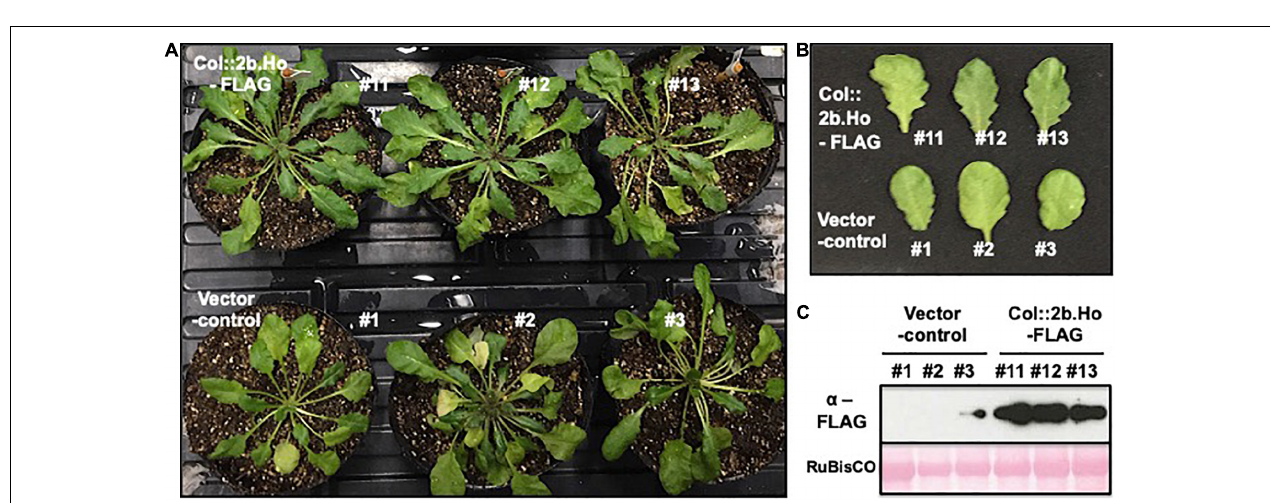
FIGURE 10 | Asymptomatic phenotype of A. thaliana ecotype Col-0 transformed with FLAG epitope sequence-tagged cDNA for 2b RNA of CMV(Ho). Three independent lines of Col-0 plants transformed with FLAG epitope sequence-tagged cDNA for 2b RNA of CMV(Ho) (Col:2b.Ho-FLAG #11, #12, and #13) and three independent lines of pRI201AN-transformed plants (vector control #1, #2, and #3), as the control, were photographed at 35 days after sowing (A) . Fully expanded leaves of the transformed and control plants were photographed (B) . FLAG-tagged 2b protein was detected immunologically by western blotting (C) . As an internal control, RuBisCO was detected by Ponceau-S staining and shown in the lower